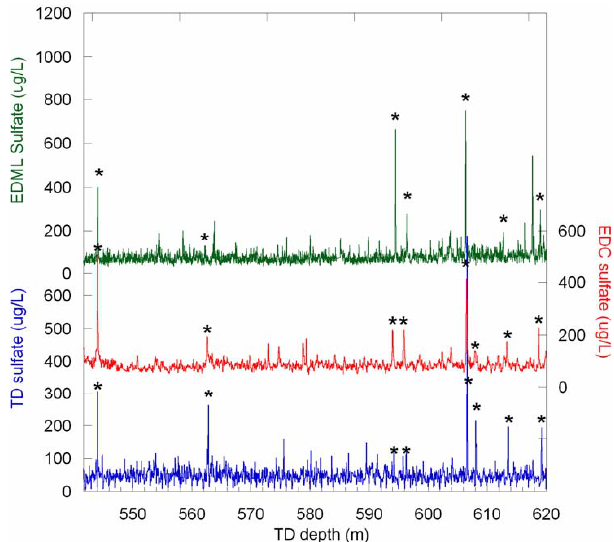
Figure 4. Synchronisation of the Talos Dome, EDML and EDC cores in the time period 3 Fig. 4. Synchronisation of the Talos Dome, EDML and EDC between 8.5 and 10.4 kyr BP. The three records show a low background “noise” and several 4 cores in the time period between 8.5 and 10.4kyr BP. The three common volcanic spikes are clearly visible. Events marked with (*) have been used to build 5 records show a low background “noise” and several common vol- canic spikes are clearly visible. Events marked with * have been the stratigraphic link between the EDC and the TD ice cores. 6 used to build the stratigraphic link between the EDC and the TD ice cores.